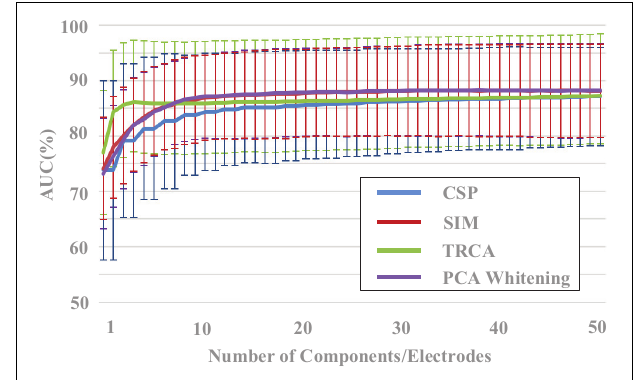
FIGURE 4 | The effect of components number on classification performance (block 1 for training, block 2 for